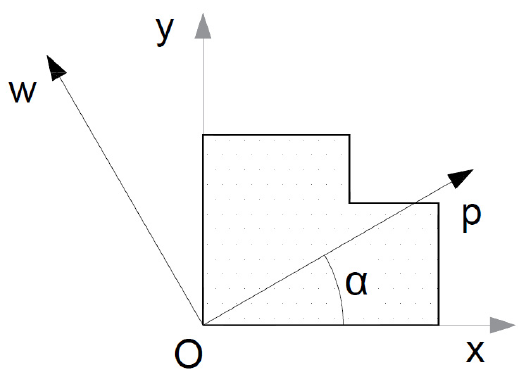
Figure 5. Definition of axes according to the angle of incidence [29]. Table 1. Set of strong motions used to perform the nonlinear response analysis